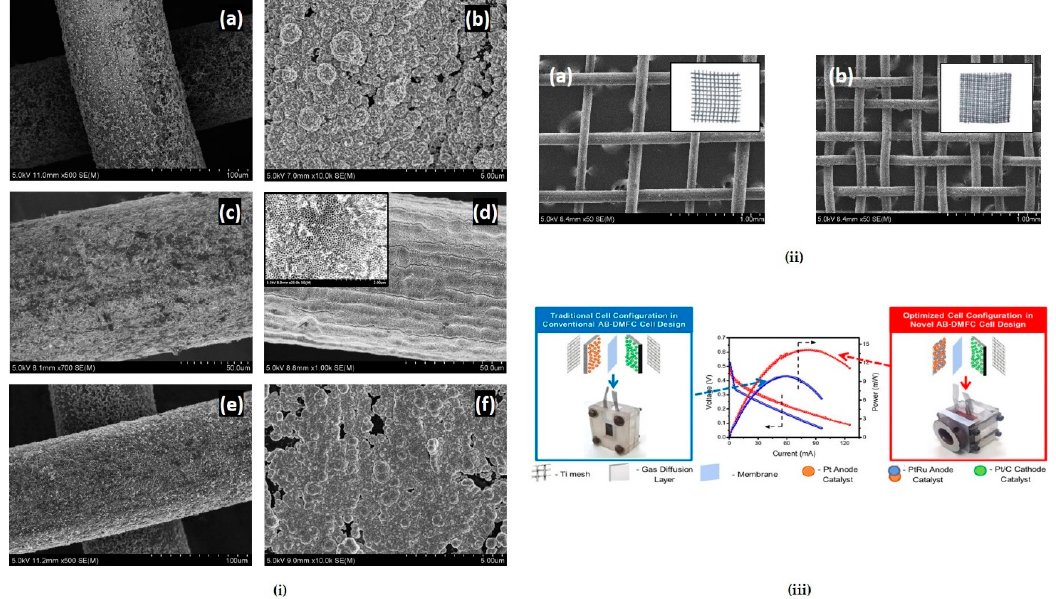
Figure 5. ( i ) Scanning electron microscope images of Pt electrodeposited on Ti mesh at ( a ) low and ( b ) high magnification. Scanning electron microscope images of ( c ) pretreated Ti mesh and ( d ) TNT/Ti mesh with high magnification image in inset showing titania nanotubes. Scanning electron microscope images of PtRu (1:1) electrodeposited on Ti mesh at ( e ) low and ( f ) high magnification. ( ii ) SEM images for Ti mesh of ( a ) 40 mesh, and ( b ) 80 mesh size, with insets showing the corresponding photographs of the mesh. ( iii ) Figure showing the air-breathing direct methanol fuel cell (AB-DMFC) and its performance with Pt-Ru catalyst deposited on Ti mesh with different configurations. Reprinted with permission from [71].